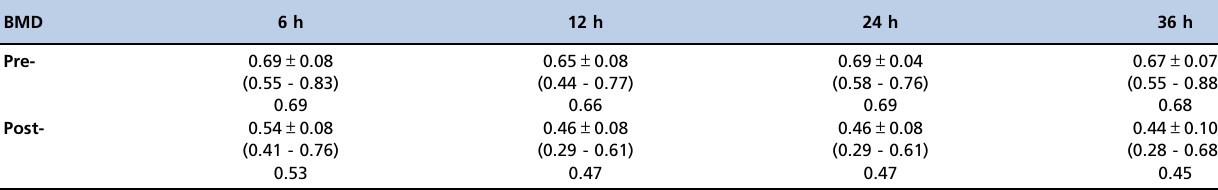
Figure 5 - Box-plot graph of UV before (light grey boxes) and after (dark grey boxes) demineralization, according to deminer- alization time. Table 2 - BMD (g/cm 2 ) data (mean ± SD, range, median) before and after demineralization according to demineralization time (hours).